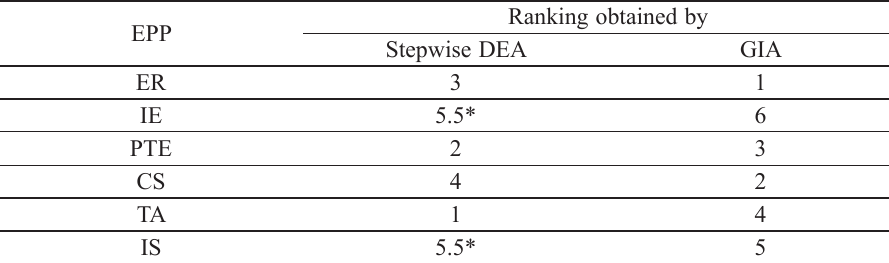
Table 7. EPPs ranking obtained by stepwise DEA and